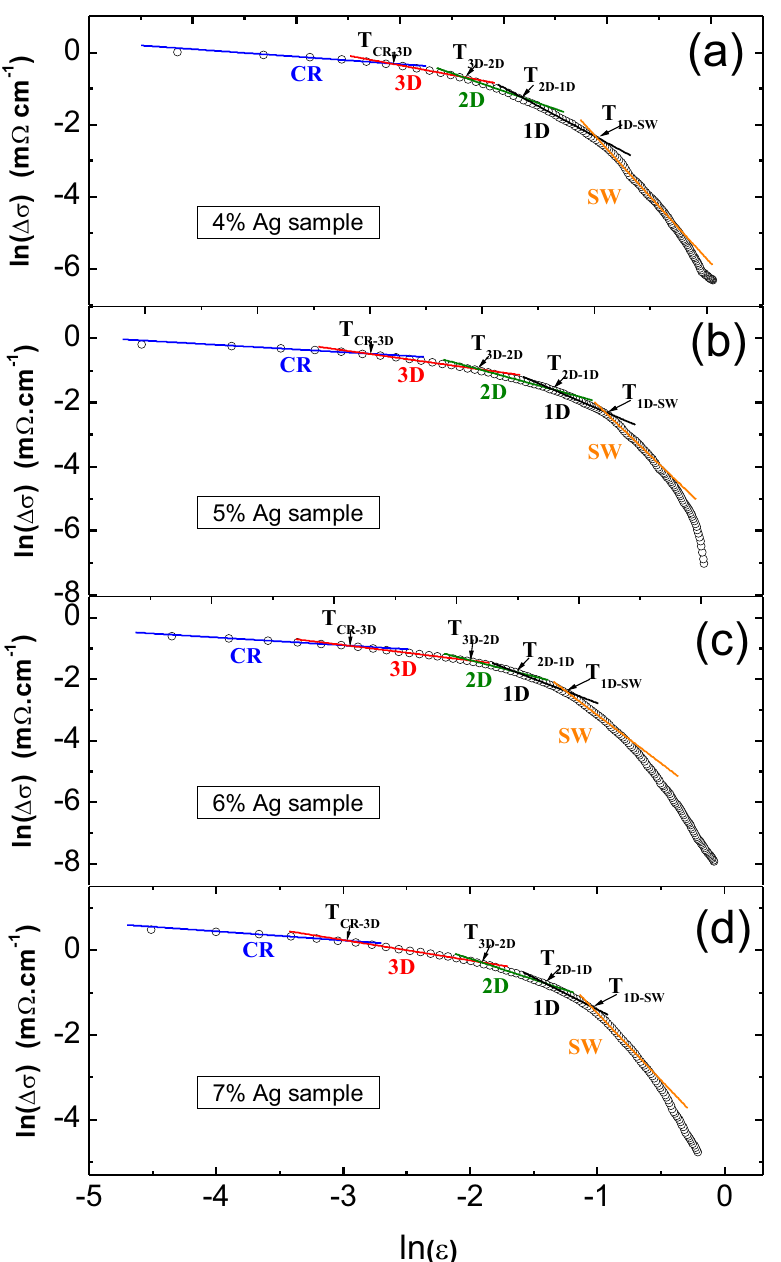
Figure 7. Analysis of the fluctuation-induced conductivity for the Ag-doped FeSe samples with ( a ) 4, ( b ) 5, ( c ) 6, and ( d ) 7 wt.% Ag addition. Note the five fluctuation regimes SW ( ), 1D ( ), 2D ( ), 3D ( ), and CR ( ) being present. Table 2. The conductivity exponents λ and the width of the mean-field regime (MFR) fluctuation regimes (3D, 2D, and 1D) as function of the Ag Table 3. Superconducting parameters of FeSe samples with silver addition determined from the FIC-analysis. Sample pure 4 wt.% 5 wt.% 6 wt.% 7 wt.%